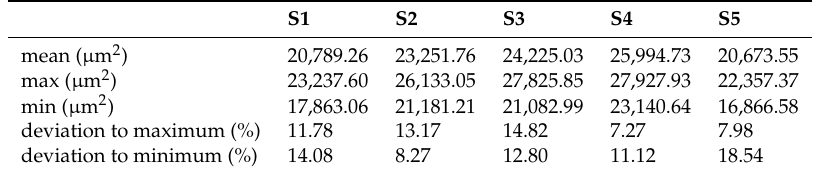
Table 2. Cross-sectional area of PU core for five struts